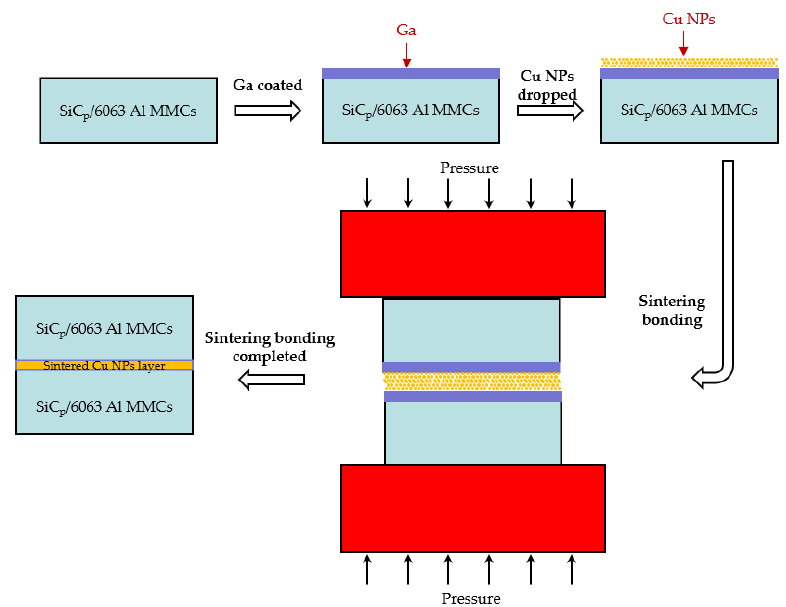
Figure 2. Schematic representation of sintering bonded SiC p /6063 Al MMCs joint.